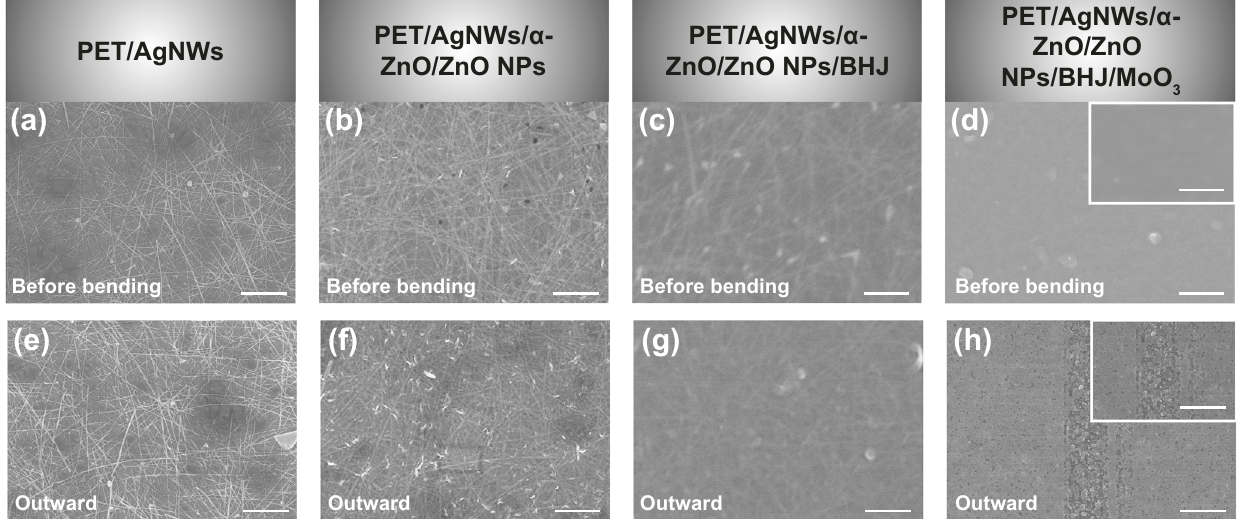
Fig. 2 Surface morphologies of FOSC fi lms before and after bending. SEM images of a , e PET/AgNWs fi lm, b , f PET/AgNWs/ α - ZnO/ZnO NPs fi lm, c , g PET/AgNWs/ α -ZnO/ZnO NPs/BHJ fi lm, d , h PET/AgNWs/ α -ZnO/ZnO NPs/BHJ/MoO cycles with a radius of 5 mm. The scale bar is 2 μ m. Insets show the magni fi ed SEM images. The scale bar of insets is 1 μ